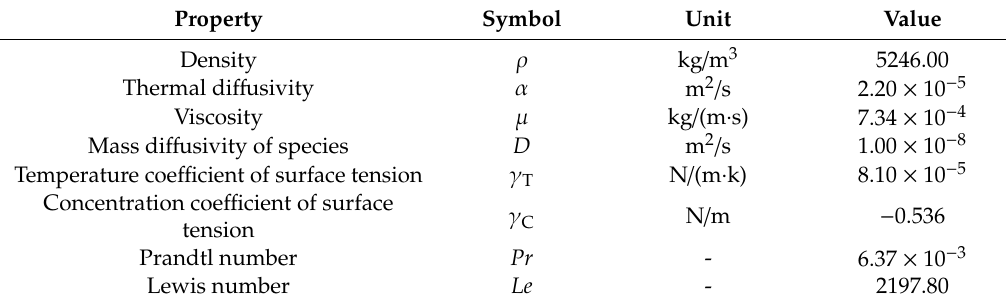
Table 1. Physical parameters of the Ge 0.98 Si 0.02